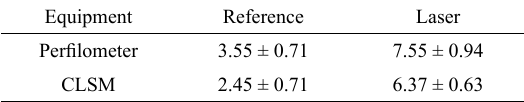
Table 1. Results of Rz roughness measurements (in µm) for both